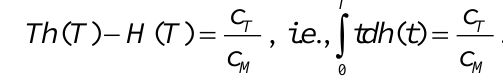
Table 1. Optimum 𝑇 ∗ and its cost rate when 𝐻(𝑡) = 𝑡 𝑚